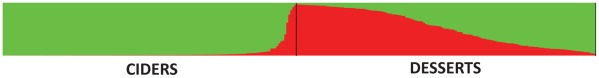
Proportions of ancestry of M. domestica genotypes (cider and dessert apples) in two ancestral genepools inferred with the STRUCTURE program.